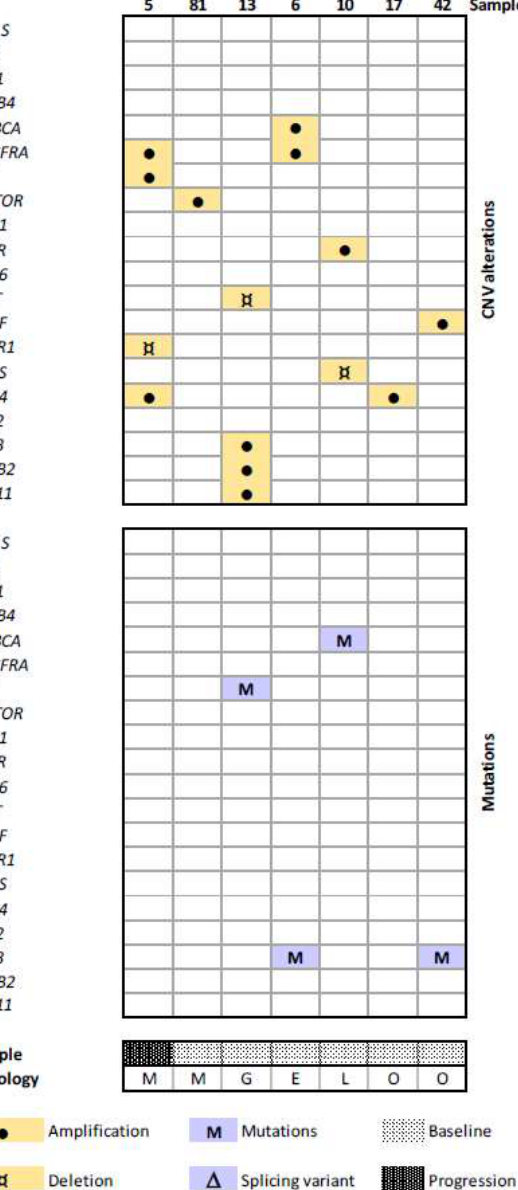
Figure 5. Heatmap of genetic alterations (mutations and CNVs) in other tumors of the validation cohort, including melanoma (M), GIST (G), esophagus (E), liposarcoma (L), and ovary (O) tumors.